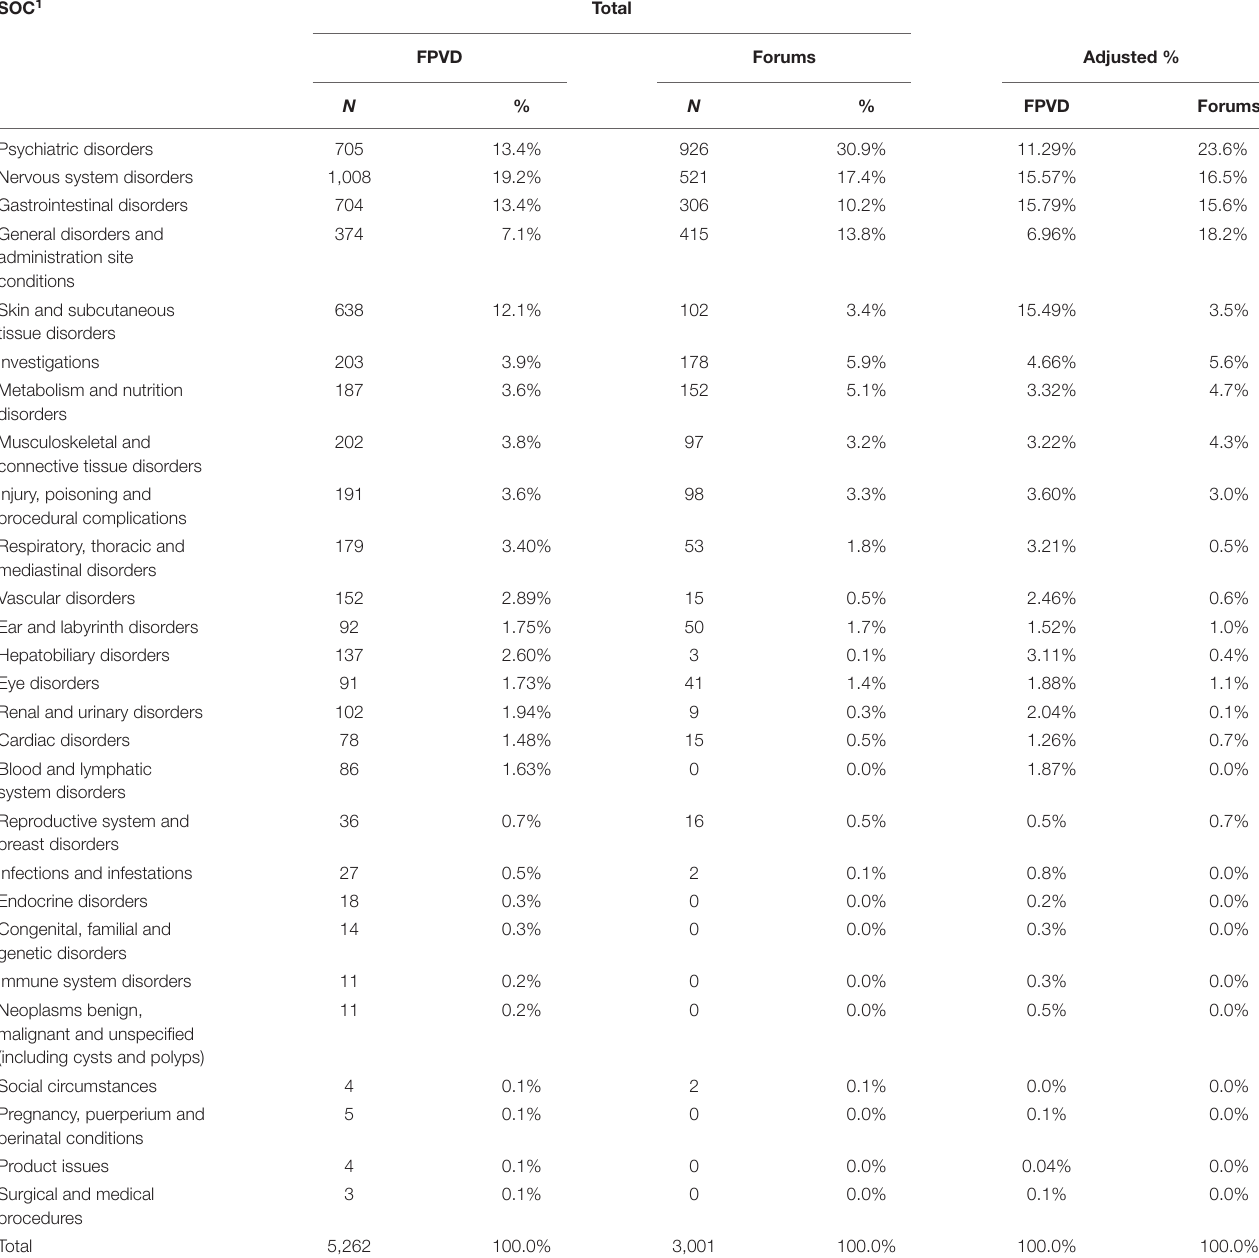
TABLE 5 | Distribution of the SOCs in the forums and the